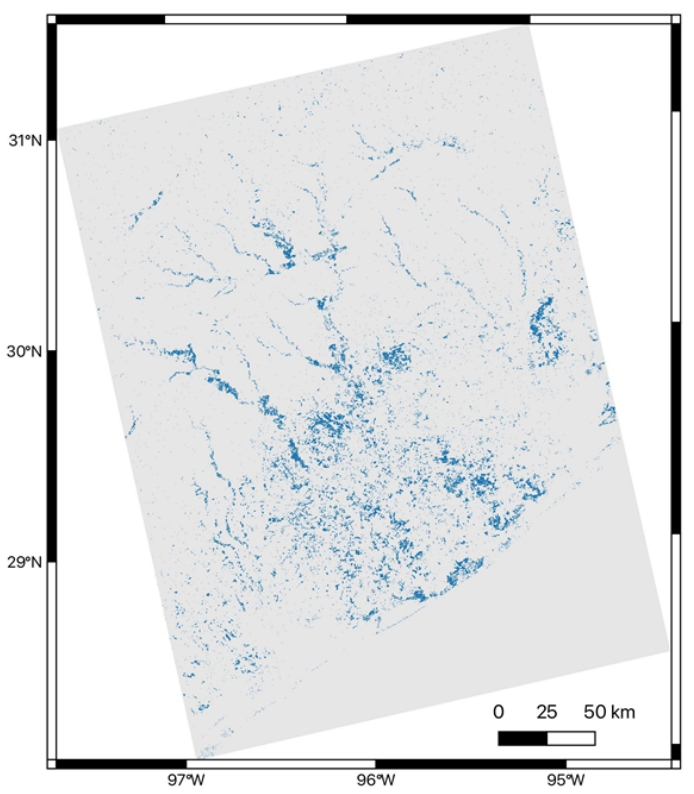
Figure 9. Results from the DeepLabv3+ ML analysis applied to the false RGB data of Figure 5b. Water pixels are shown in blue, pixel spacing is 10 m, permanent water bodies removed using the GWM.